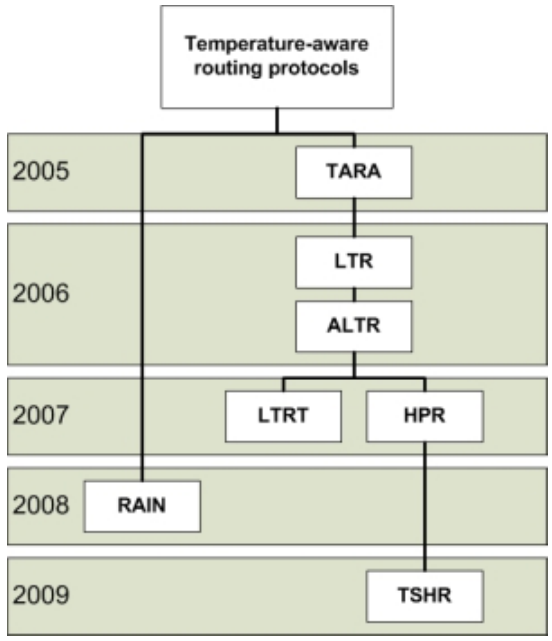
Figure 2. The taxonomy of temperature-aware routing protocols in